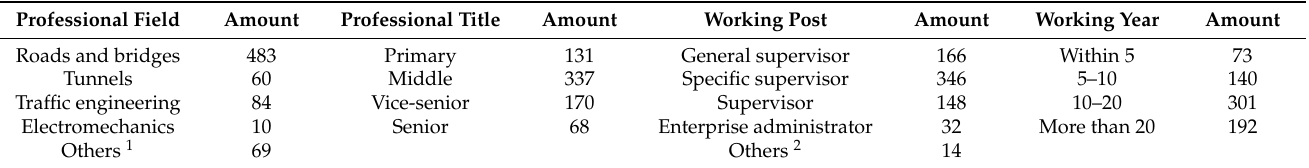
Table 6. Basic information of